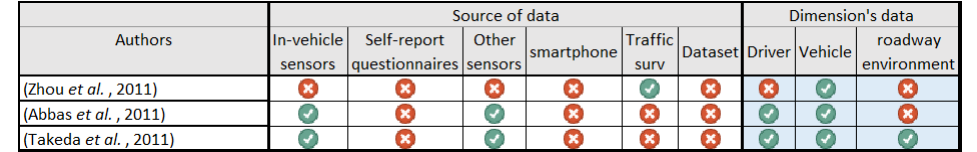
Figure 5. Example of extracted data